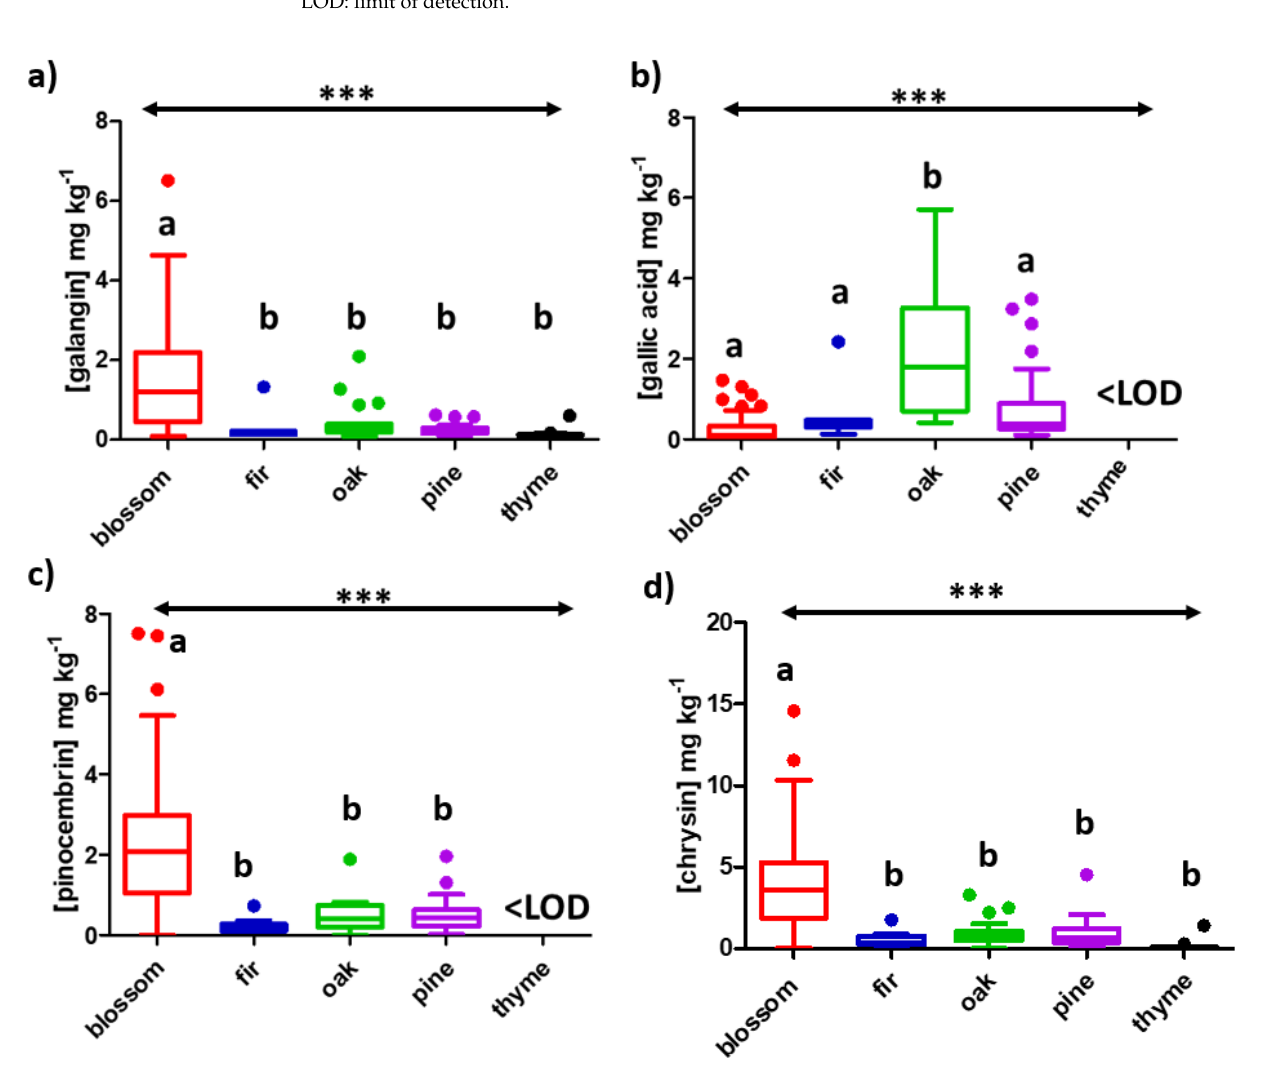
Figure 1. Whisker’s plot for ( a ) galangin, ( b ) gallic acid, ( c ) pinocembrin and ( d ) chrysin performed at the 95% confidence level; ***: p -Value < 0.001. Tukey’s multiple comparison test was also performed, and different letters indicate significant differences among the